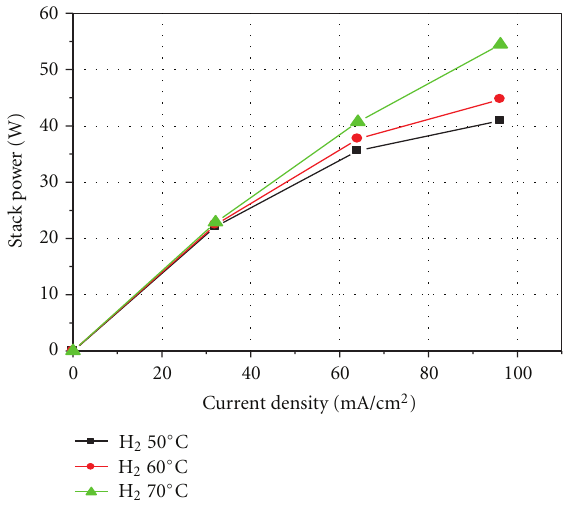
Figure 4: Fuel cell performance at di ff erent humidity.